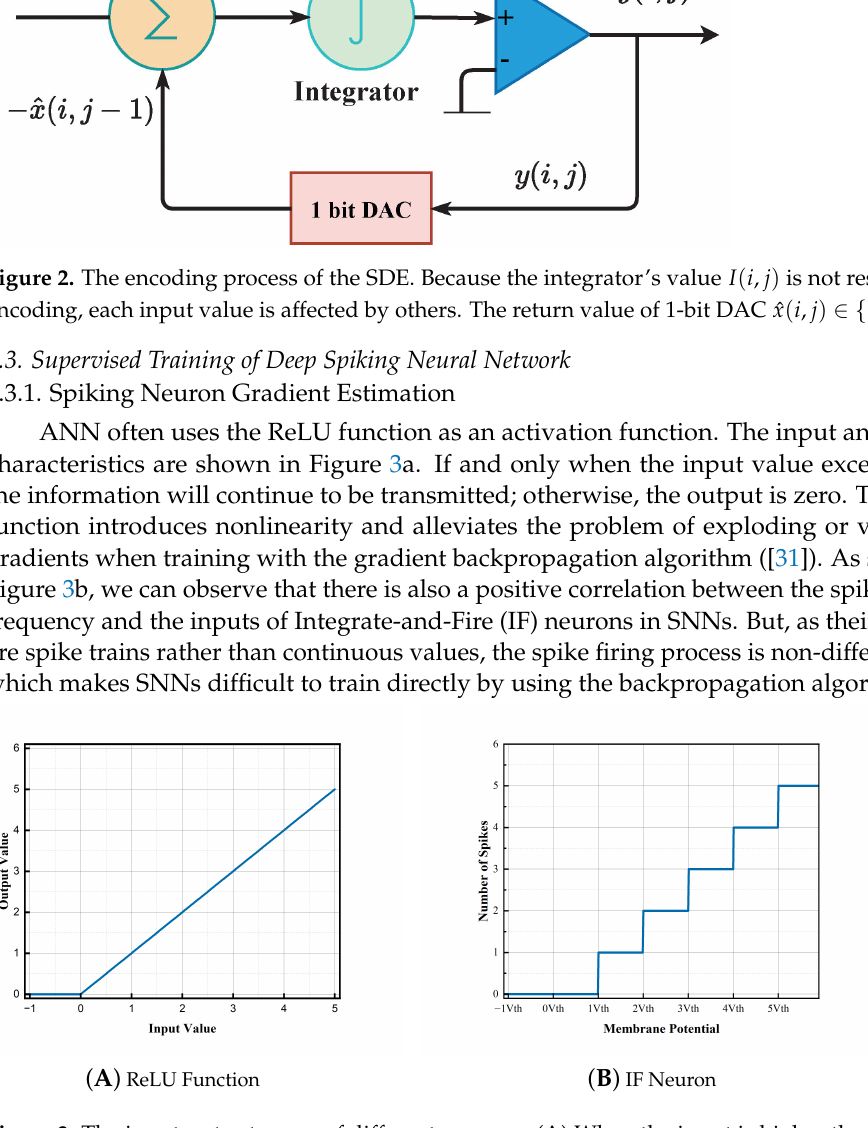
Figure 3. The input-output curve of different neurons. ( A ) When the input is higher than zero, the output is equal to the input, and the gradient is 1; otherwise, the output and gradient are both 0. ( B ) Spiking neurons fire only when the membrane potential exceeds the threshold, and the process is